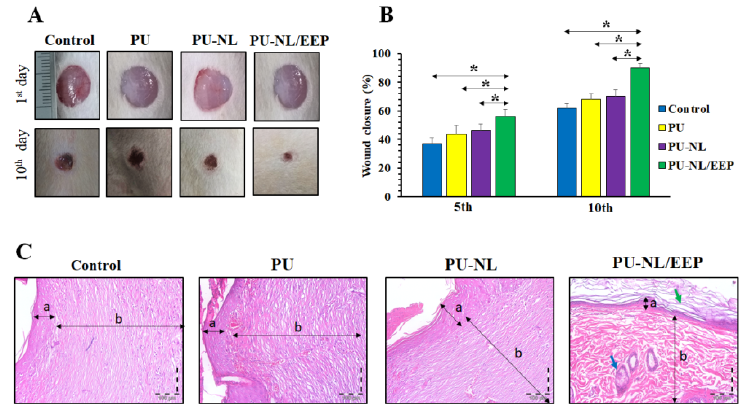
Figure 7. ( A ) Macroscopic appearances of the wounds at the 1st and 10th days post-operation at the PU, PU-NL, and PU-NL/EEP groups. ( B ) Histograms of the wound closure progression of the PU, PU-NL, and PU-NL/EEP groups. The data are expressed as mean ± standard deviation, (n = 8, *: p <0.05, ns: not significant). ( C ) H&E stained sections of skin specimens from the wound site of the PU, PU-NL, and PU-NL/EEP groups. Two-head arrows indicated by a and b letters indicate the epidermis and dermis layers, respectively. Also, the green and blue arrows indicate the keratin layer and sebaceous gland, respectively.